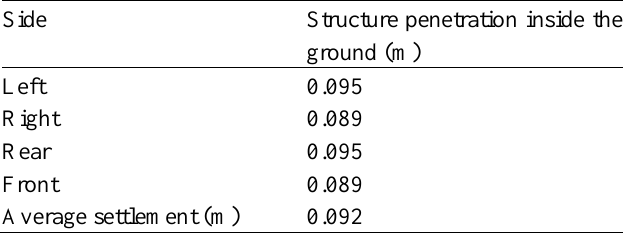
Penetration of Structure inside the Ground in Treated 1-g Physical Model-I with Treatment Adjacent to Structure